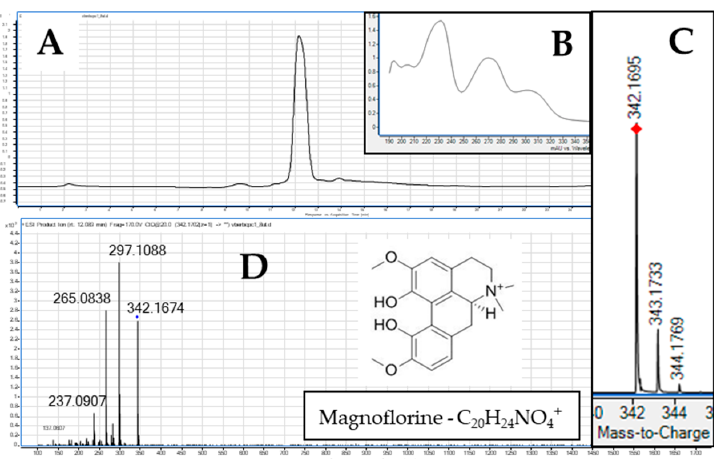
Figure 1. The purity of the isolated magnoflorine ( A ) presented in the mass chromatogram, its UV spectrum ( B ), the isotopic distribution of the parent ion ( C ), and the fragmentation spectrum ( D ) obtained at the collision energy of 20 V in the HPLC-MS